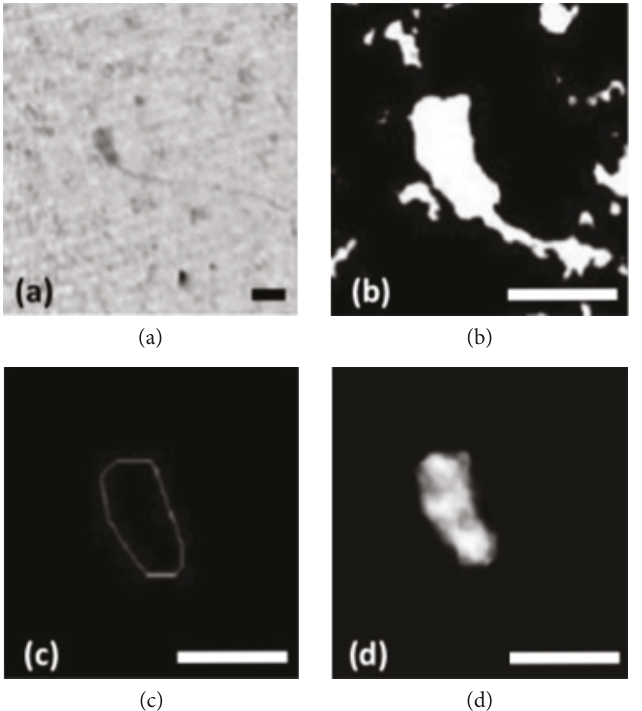
Figure 5: Volume estimation procedure from the phase map. (a) Phase map. (b) Selected head region by Otsu ’ s threshold method. (c) Polygonal interpolation. (d) Final estimated sperm head volume. Scale bars: 5 μ m [7].